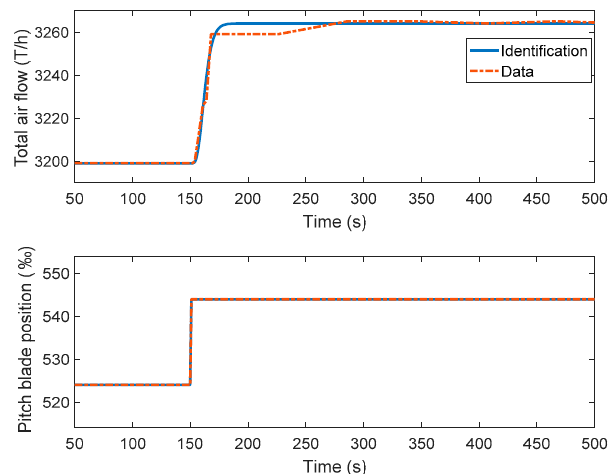
Figure 7. Open loop identification of the total air flow control process.